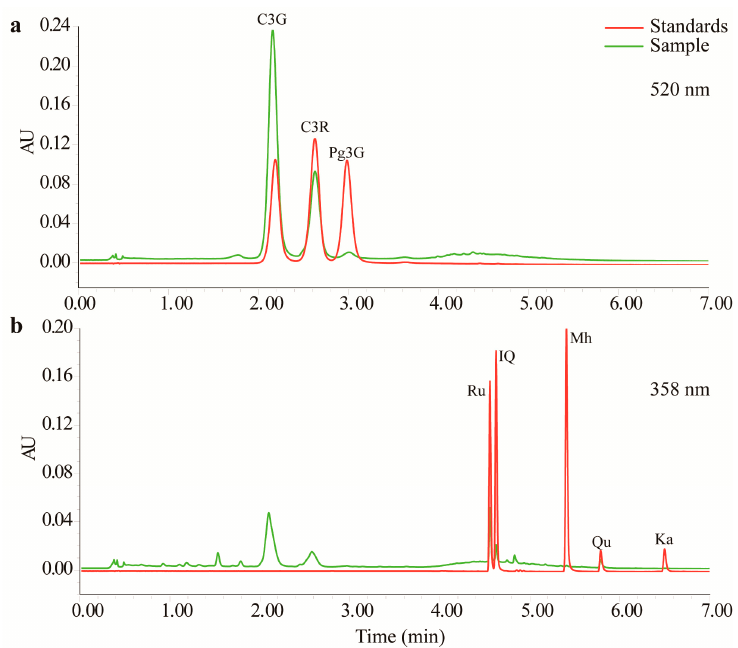
Figure 1. Chromatograms of anthocyanins ( a ) and flavonols ( b ) obtained by UPLC–TUV/QDa.